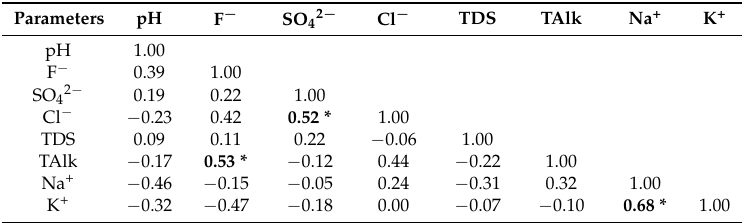
Table 2. Other physicochemical parameters in three drinking water sources of Yancheng City. Drinking water